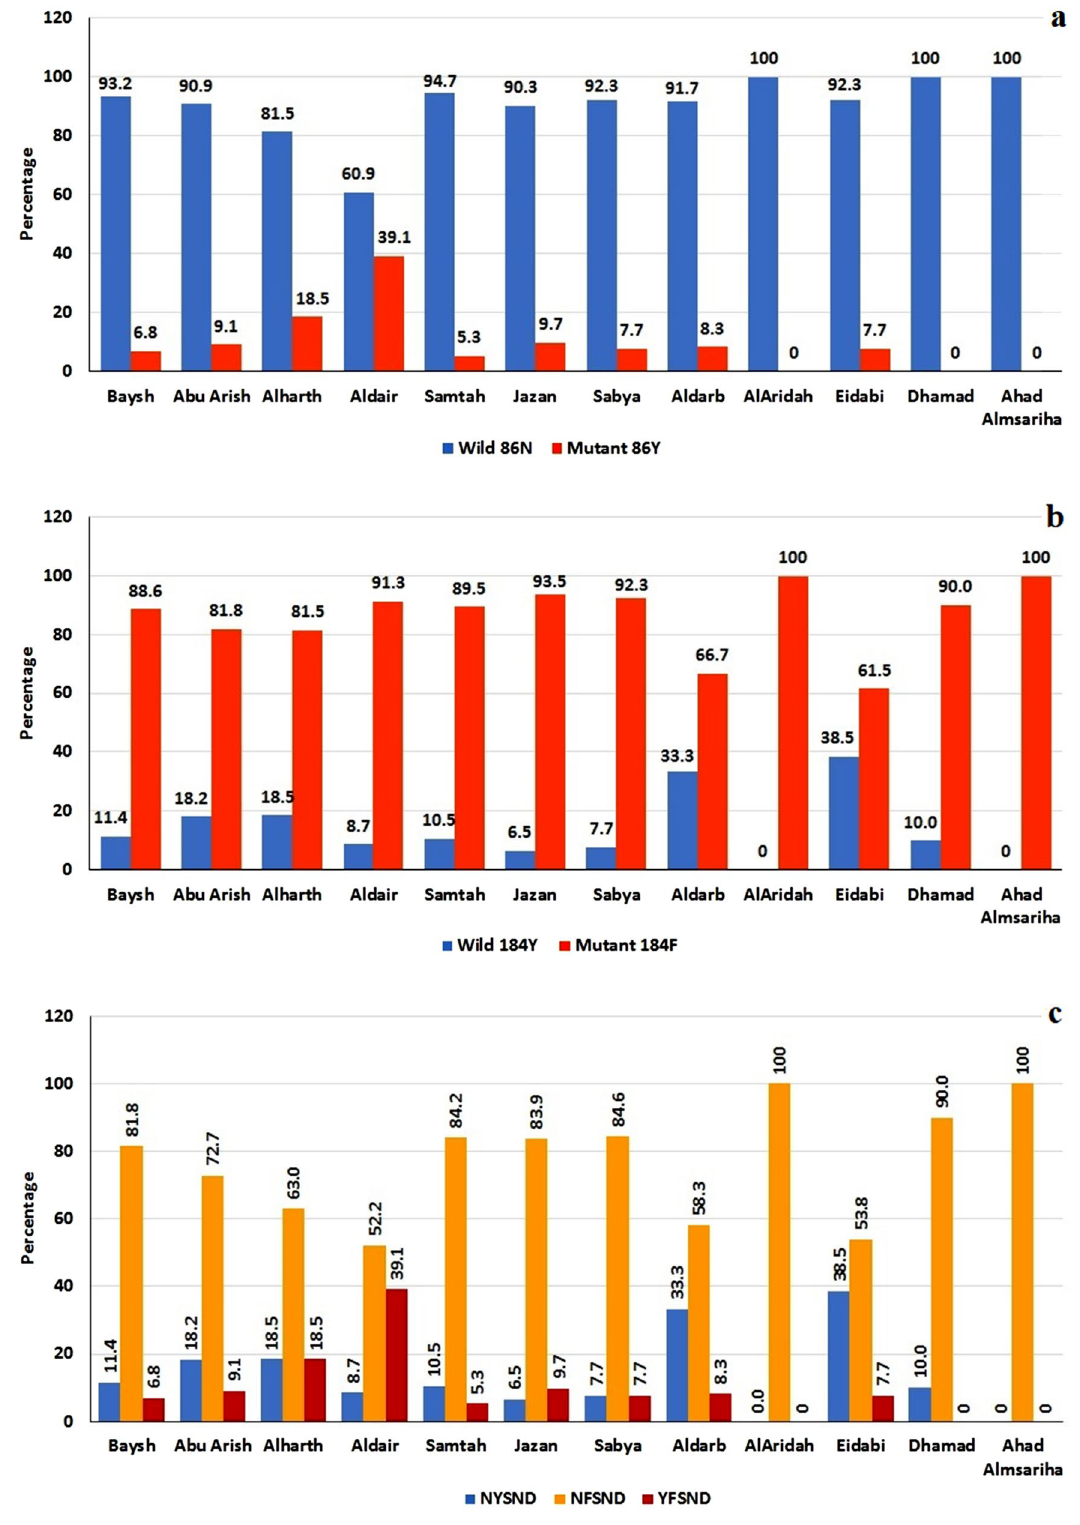
Figure 2. Distribution of pfmdr1 N86Y and Y184F mutations and haplotypes according to governorates involved in the study in Jazan region. ( a ) pfmdr1 N86Y. ( b ) pfmdr1 Y184F. (c) pfmdr1